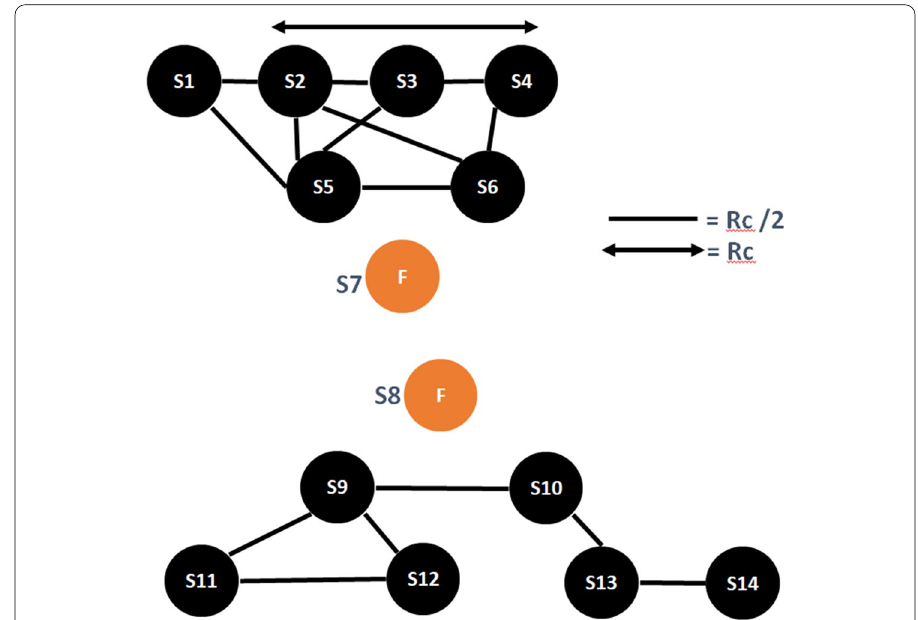
Fig. 5 Two cut-vertex nodes